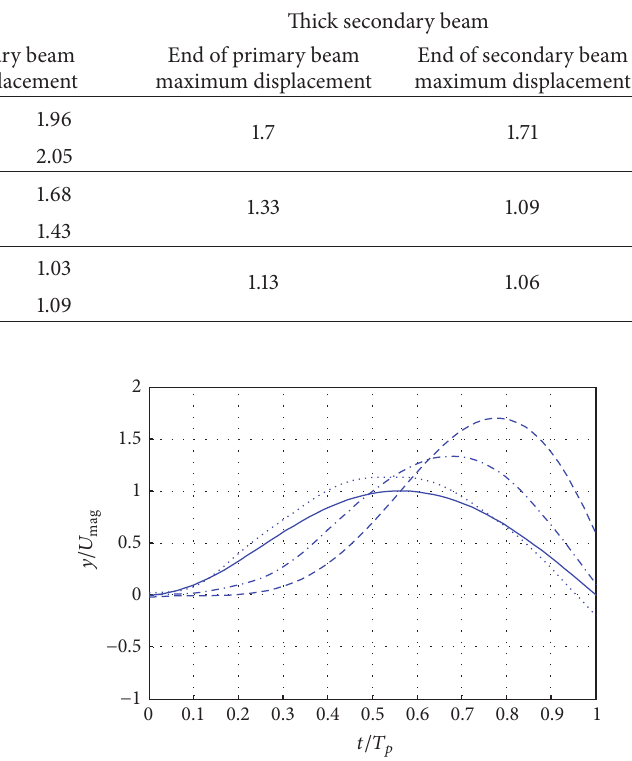
Figure 26: Comparison between measured displacement responses at the end of the primary beam with different levels of friction for the case of the thick secondary beam. Solid line: base input. Dashed line:nofriction.Dash-dottedline:intermediatefriction.Dottedline: high